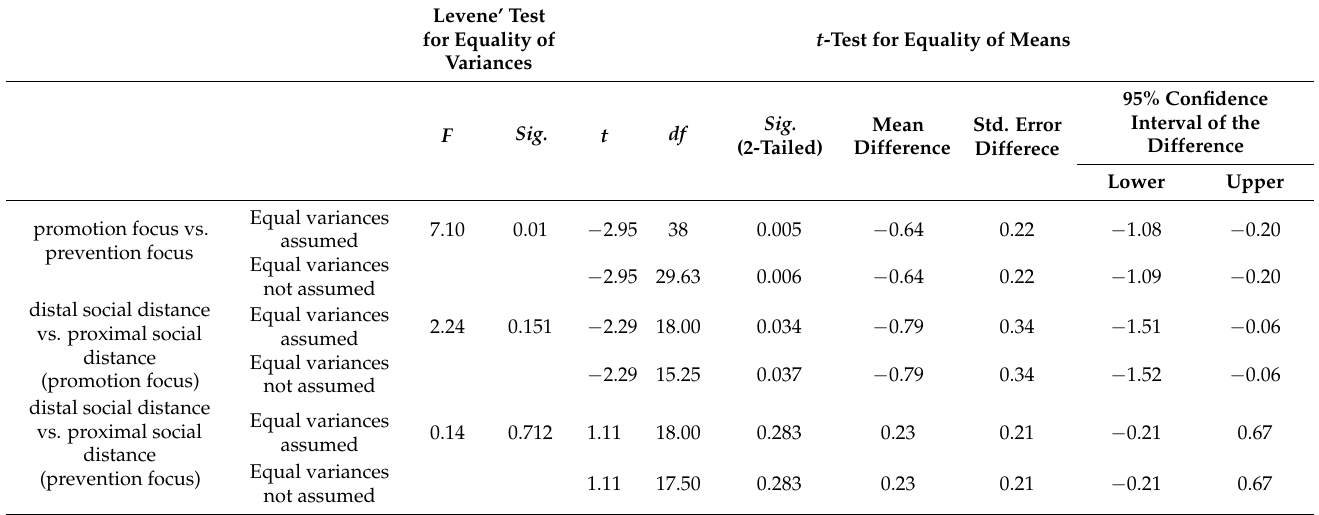
Table 3. Independent samples test (change range of willingness to accept